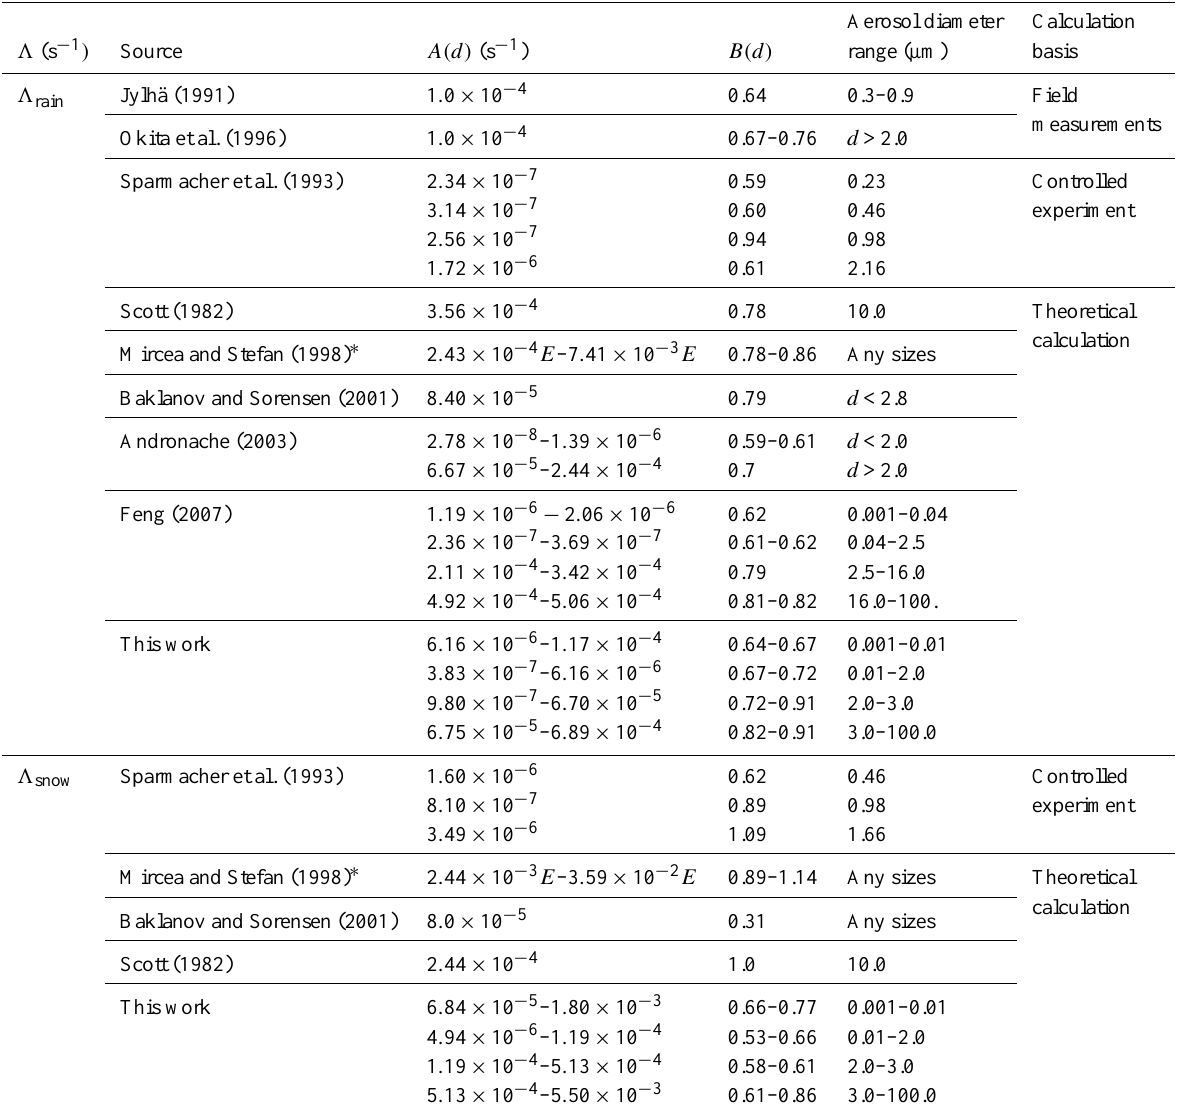
Table 9. List of below-cloud 3 rain and 3 snow parameterizations from literature expressed as 3(d,R) = A(d)R B(d) (where 3 is in units of s − 1